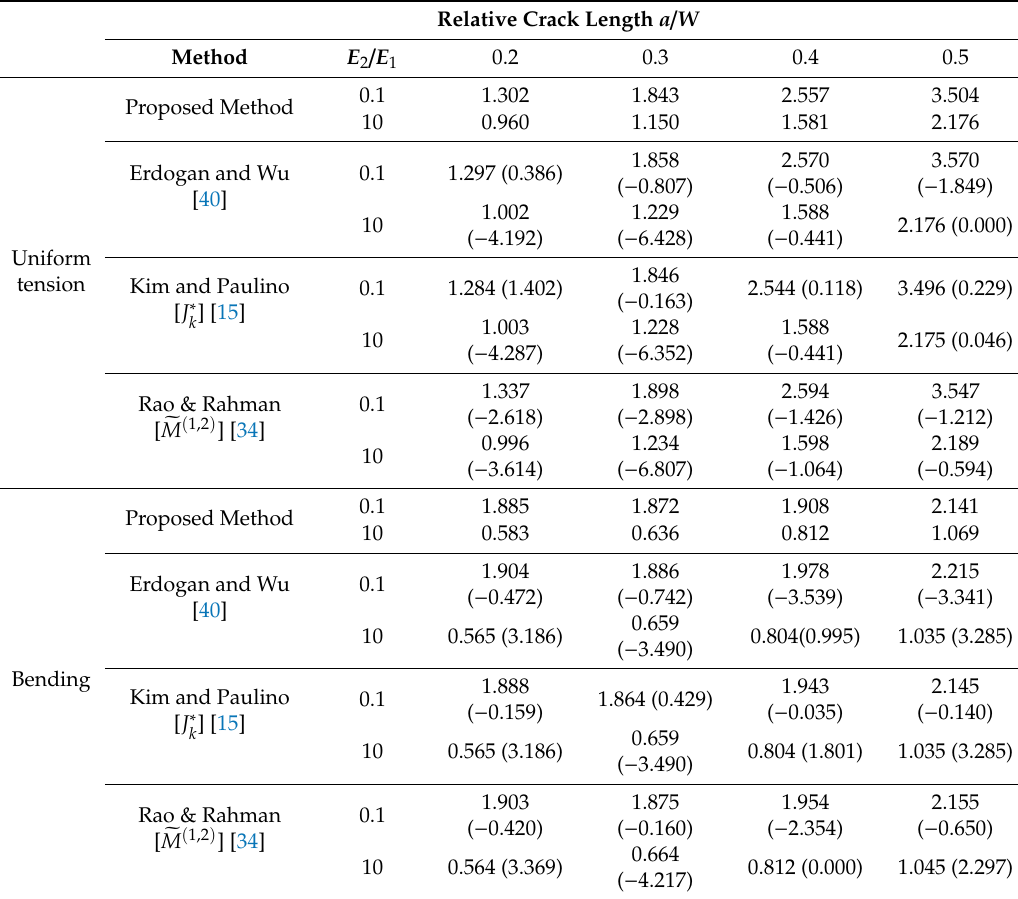
Table 1. Normalized stress intensity factors K I / σ yy